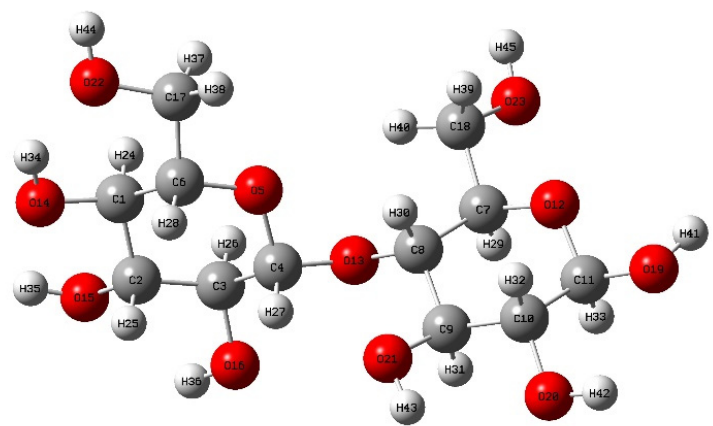
Figure 1. Molecular structure of cellobiose.